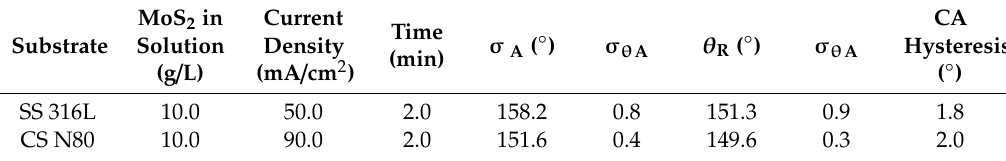
Table 4. Advancing and receding contact angle with respective standard deviations and contact angle hysteresis obtained by composite electrodeposition of a Cu–MoS 2 coating on a SS 316L (A) and CS N80 (B) substrate.